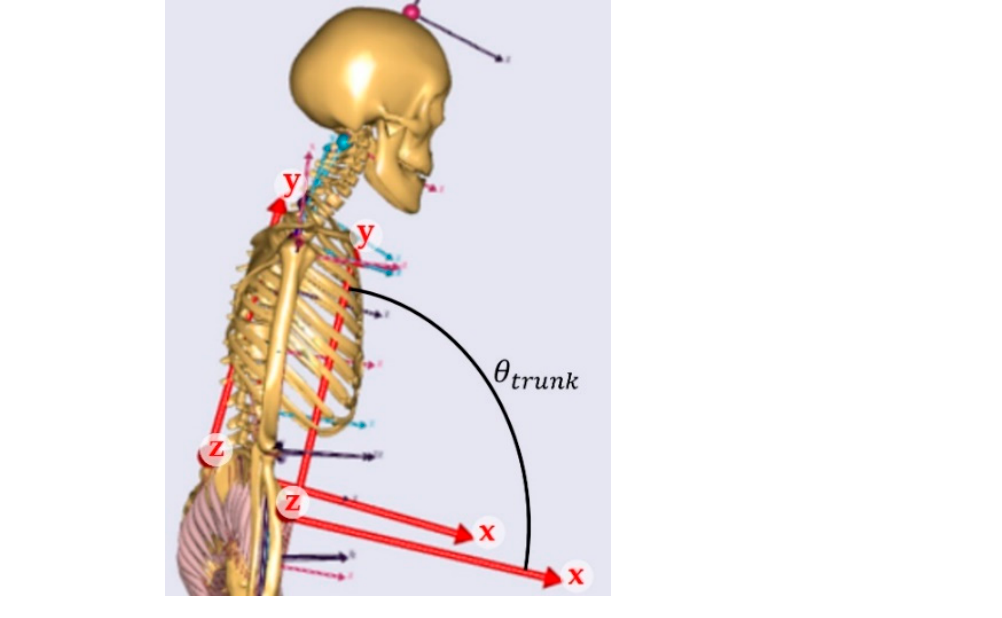
Table 2. Completion time and heart rate for ten subjects ( n = 10), presented as mean ± SD in the case of normal distribution ( † ) or median + range in the case of non-normal distribution, ANOVA test results, and differences between loading conditions. The asterisks indicate significant differences between the conditions based on post hoc test results: * p < 0.01, ** p < 0.001. Significant results are in bold.